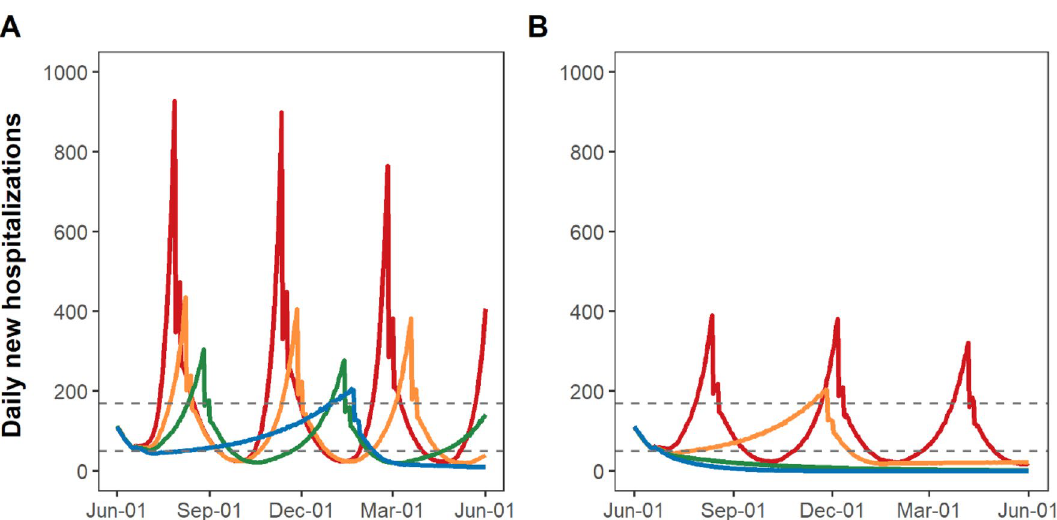
Figure 3. Daily COVID-19 new hospitalizations under resumption and relaxation of restrictions between June 2020 and May 2021: ( A ) without adherence to social distancing and ( B ) with 50% adherence to social distancing. Each colored line indicates the level of mask adherence at 0% (red), 50% (orange), 70% (green) or 90%